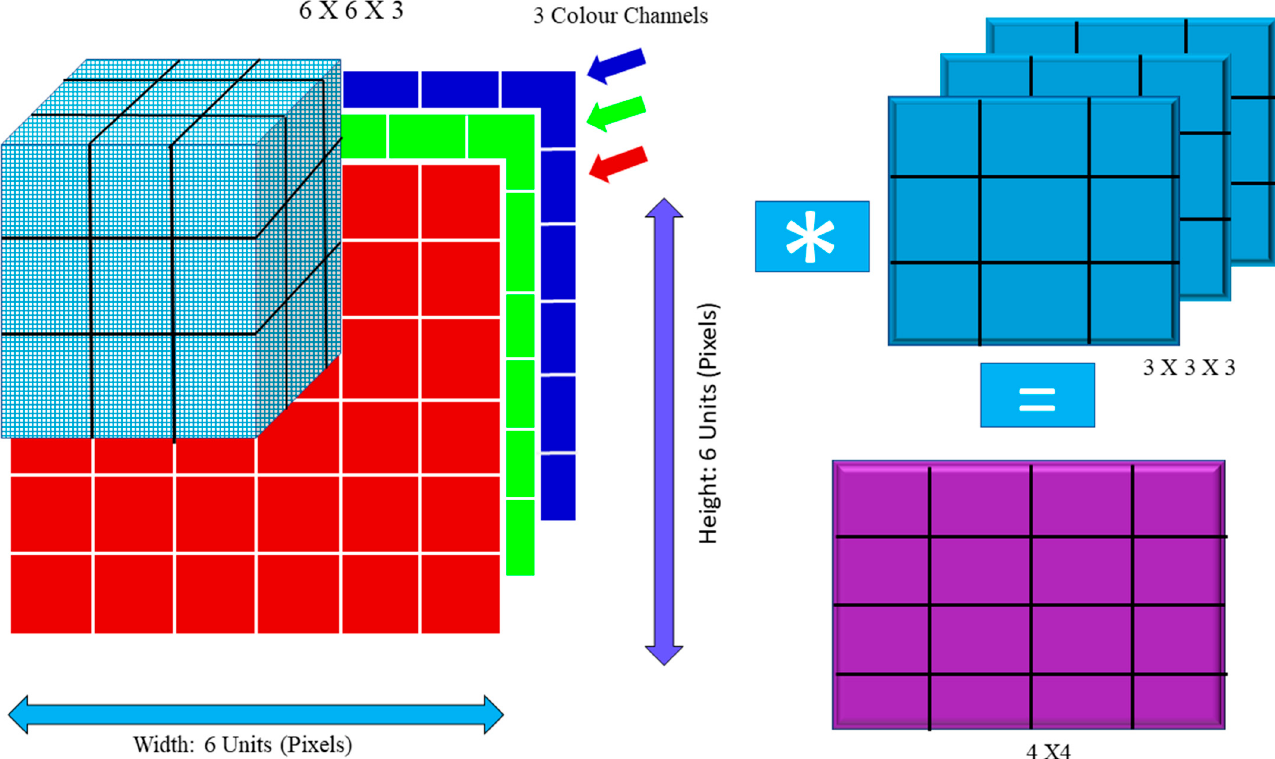
Figure 1. Convolution Operation: Image Matrix Multiplies Kernel or Filter Matrix.